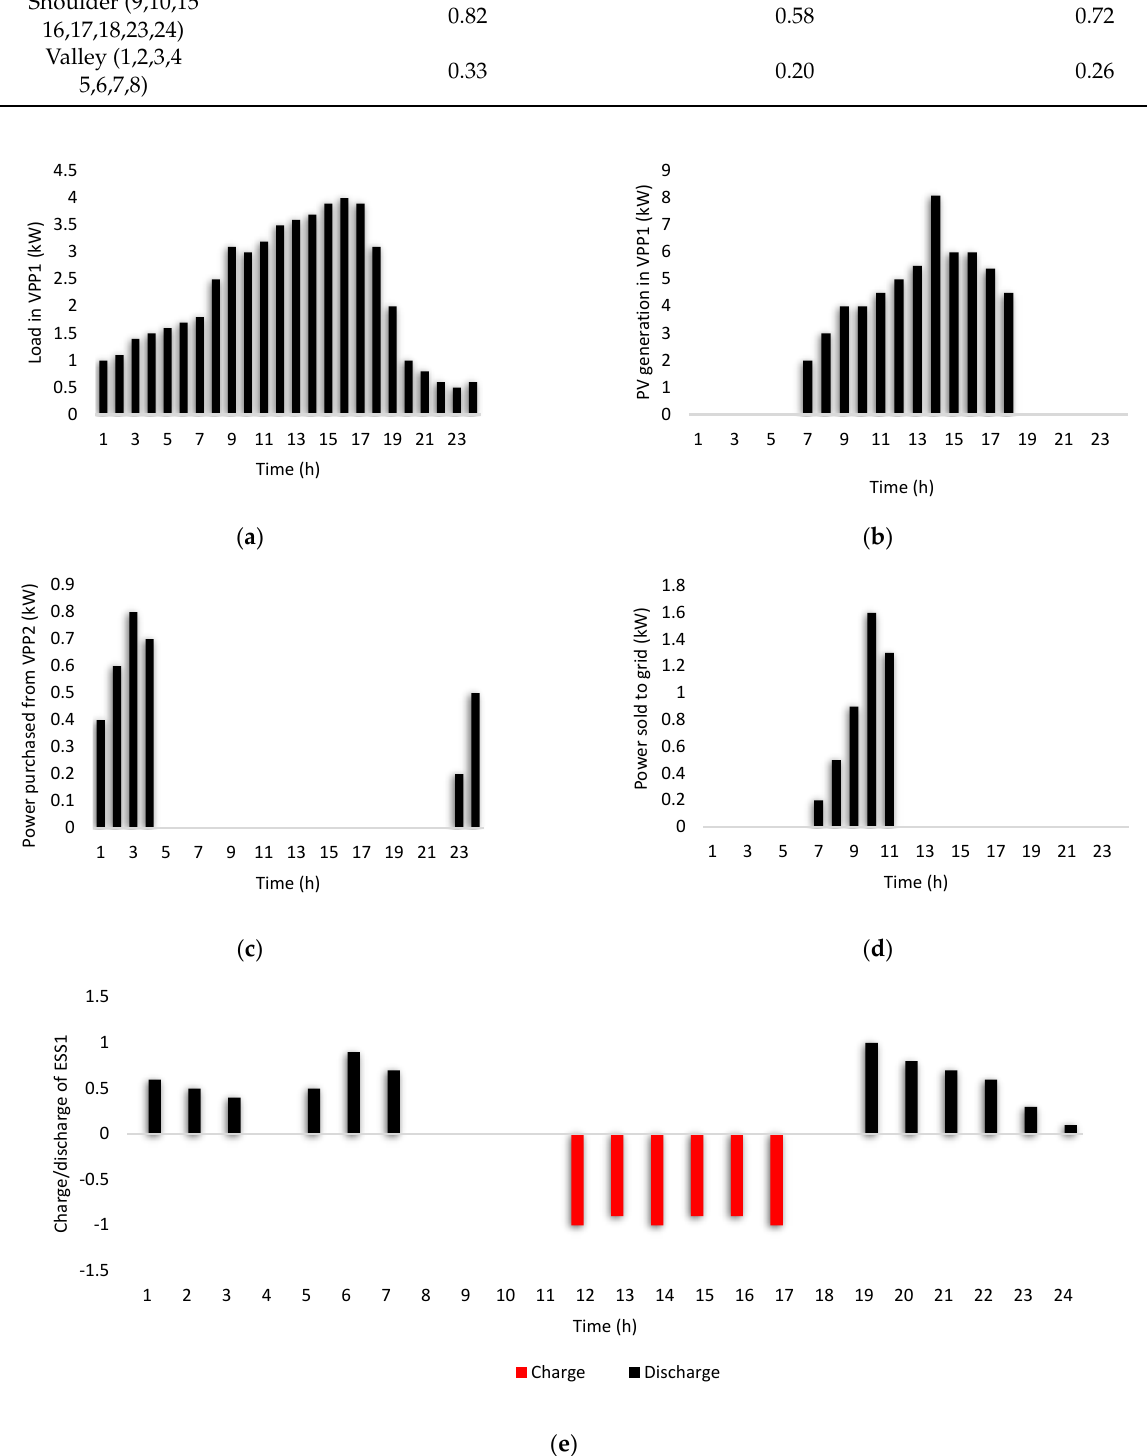
Figure 7. ( a – e ). Cooperation characteristics of virtual power plant 1.